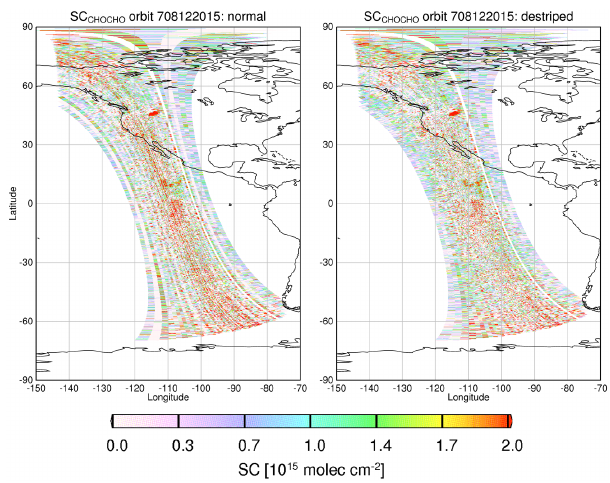
Figure 7. Glyoxal SCs retrieved from OMI data (orbit 708122015) with (right) and without (left) destriping